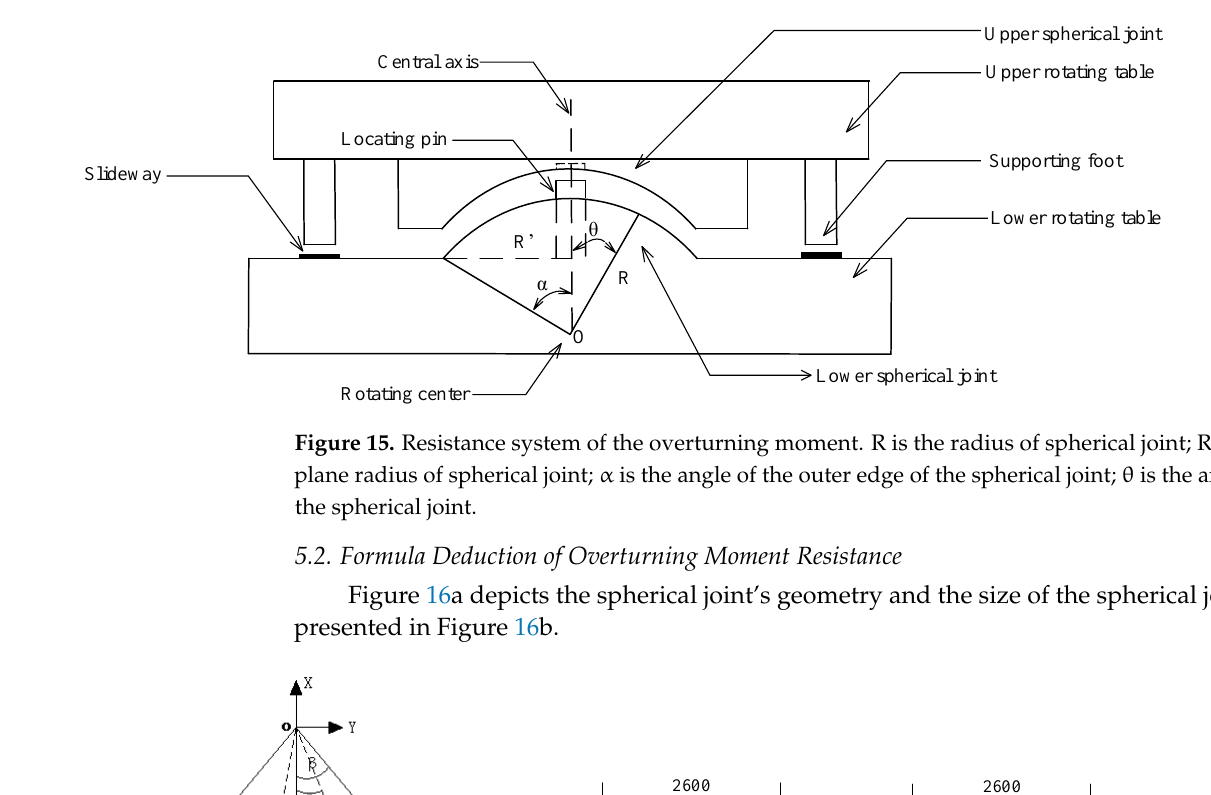
Axis of gravity M 1 M 2 Obliquity of the back wall Figure 14. Overturning moment calculation. The overturning moment and rear-wall inclination angle are calculated using the fol- lowing formula: